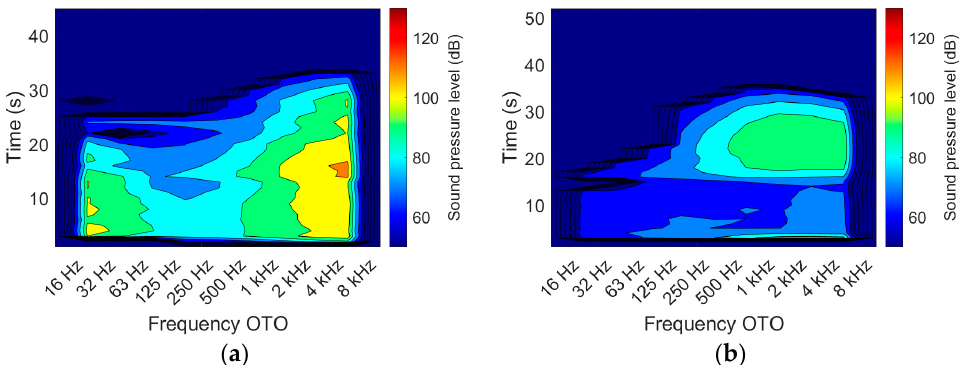
Figure 11. SPL as a function of time and OTO (One-Third Octave bands) frequency throughout FK-5-1-12 discharge by ( a ) standard and ( b ) silent nozzle for low ceiling applications with 6 mm orifice diameter.